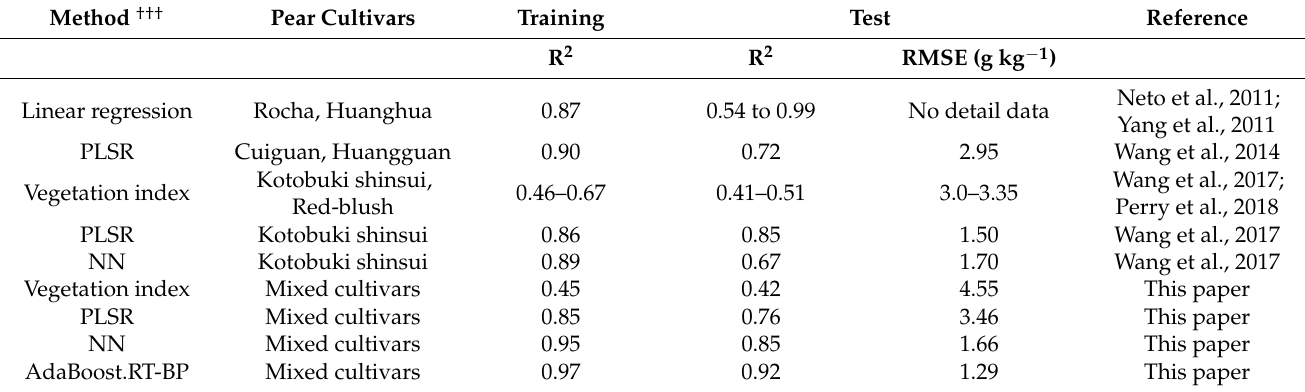
Table 5. The coefficients of determination (R 2 ) of training and test, mean relative error of test (MRE) for estimating nitrogen concentration of pear leaves in comparative